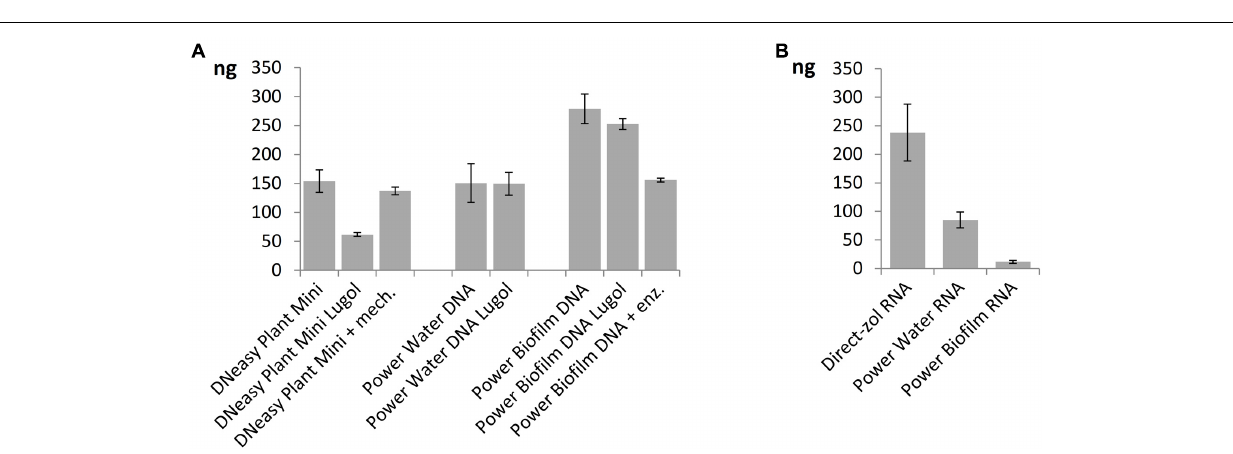
FIGURE 5 | Yields of nucleic acids from the mock phytoplankton community using (A) three DNA extraction kits with or without Lugol preservation or extra enzymatic or mechanical cell lysis steps and (B) three RNA extraction kits. All but Lugol stored samples were preserved at − 80 ◦ C. Total extracted DNA or RNA yields are presented as mean values of three isolations with standard